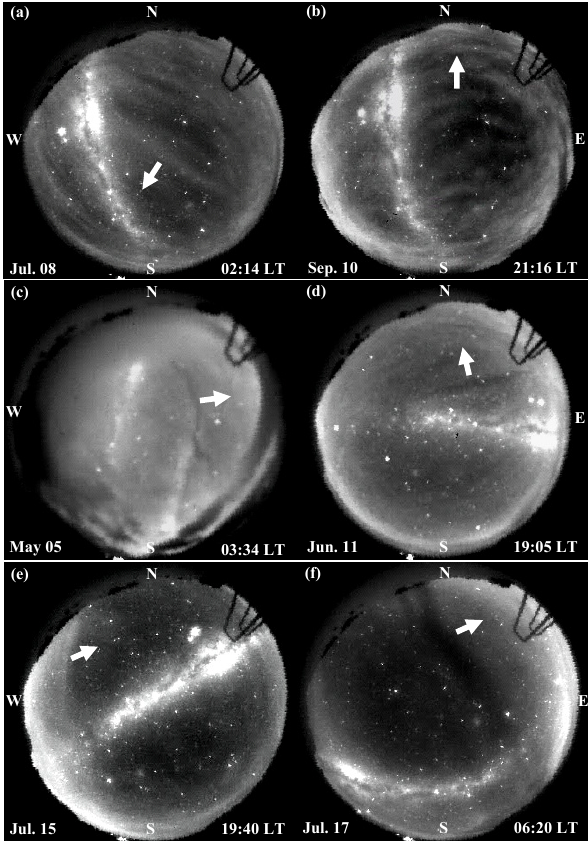
Fig. 2. Examples of atmospheric gravity waves observed at CF. Band type waves are presented in (a) and (b) ; solitary pulses in (c) and (d) ; mesospheric fronts in (e) and (f) . The white arrows in the images indicate the wave propagation